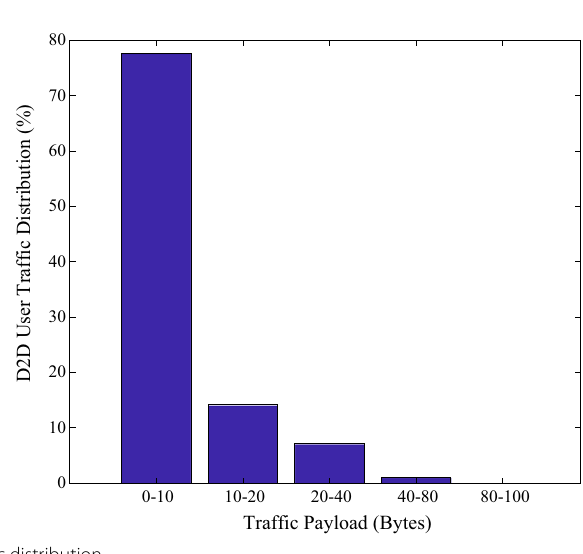
Fig. 7 D2D traffic